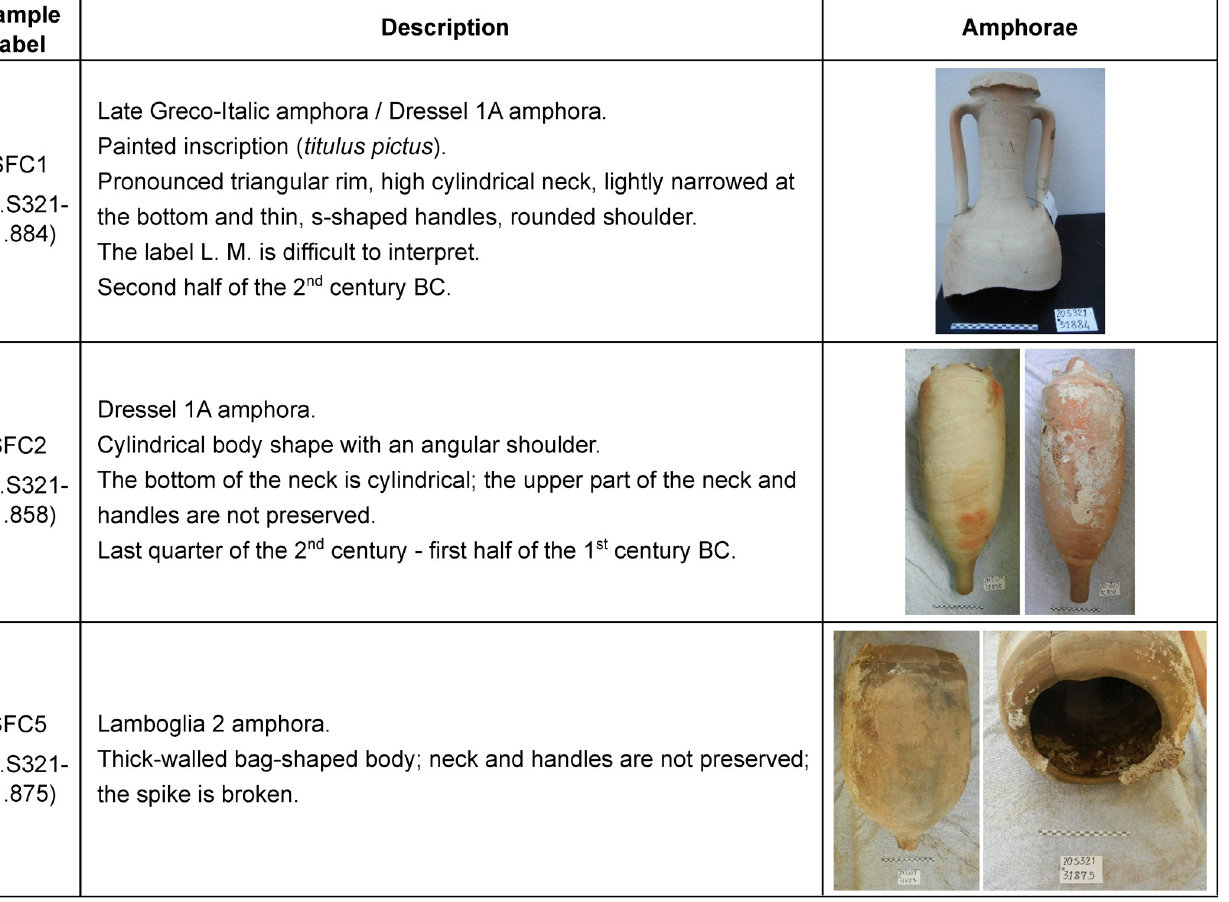
Fig 1. Investigated archaeological amphorae.